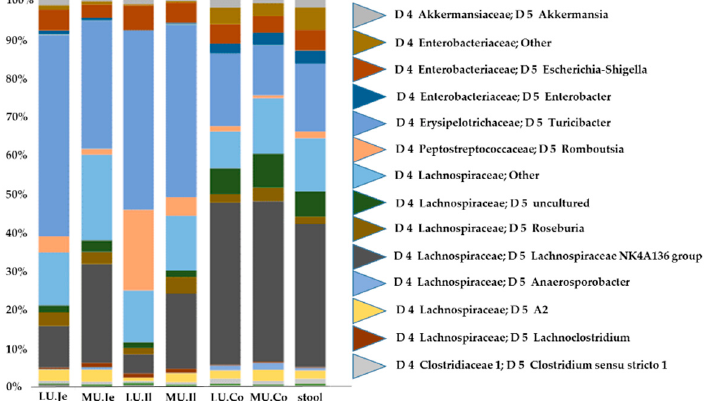
Figure 5. Bar charts of relative abundances of bacterial genera in the lumen (LU) and mucosa (MU) along the murine gastrointestinal tract (jejunum, ileum, colon, feces) over all mice studied. The 29 most abundant genera are presented (14 most dominant named individually), with at least 1% relative abundance in at least one of the analyzed groups.